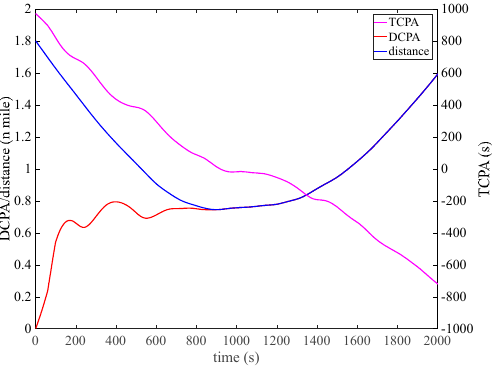
Figure 14. The curves of ship encounter parameters with time in overtaking situation.